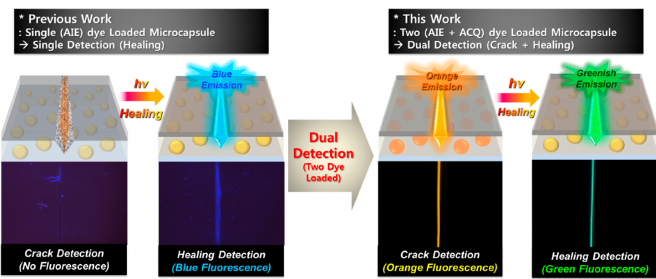
Figure 1. Schematic diagram of dual monitoring of cracking and healing using microcapsules loaded with two fluorescent dyes. Molecules 2019 , 24 , x